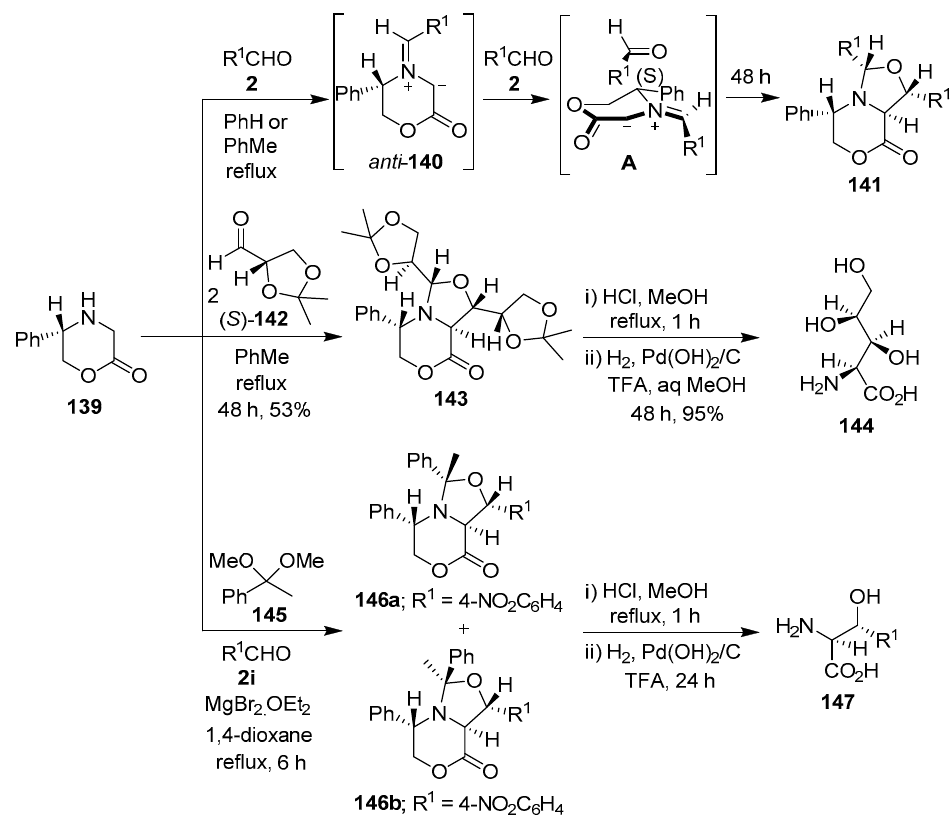
from 5-( S )-phenylmorpholine-2-one ( 139 ) and aldehydes 2 , 142 or acetophenone dimethyl acetal ( 145 ),